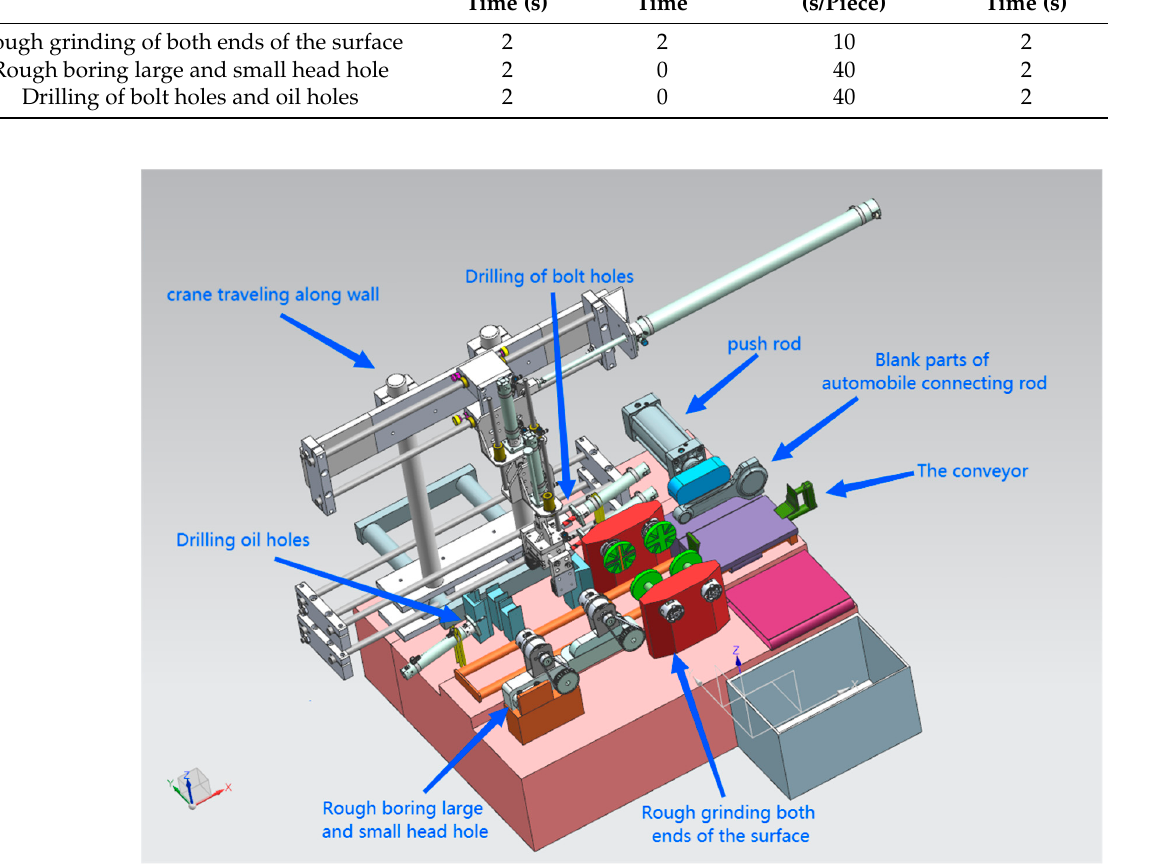
Figure 5. The model of the first part of the processing